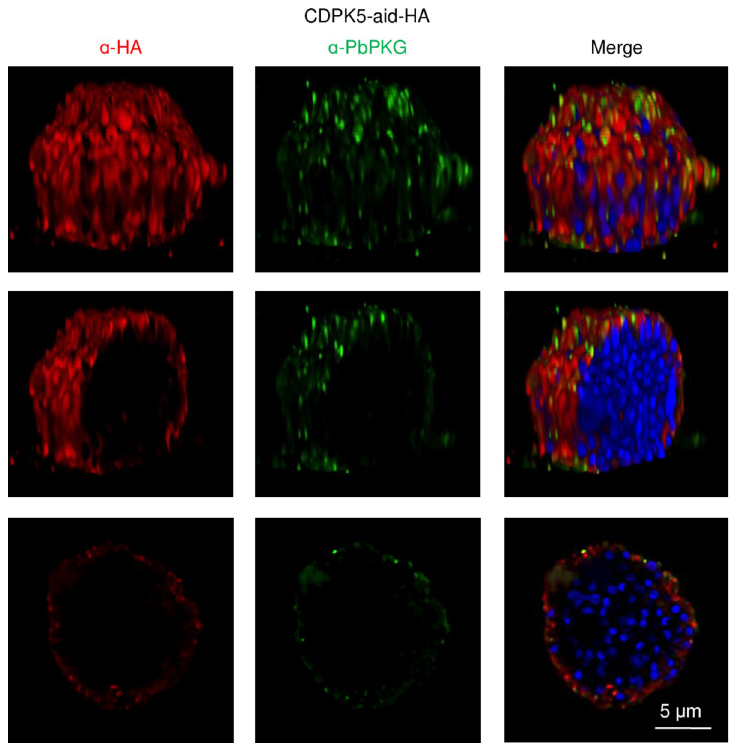
Fig 2. CDPK5 and PKG are present in the periphery of merosomes. Representative deconvolved images and optical sections of immunostained CDPK5-aid-HA merosomes. The top panel illustrates a volumetric view of a merosome. Middle and bottom panels illustrate longitudinal optical sections of the